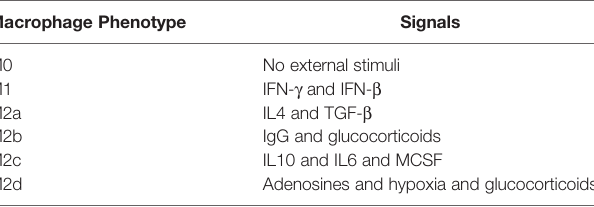
TABLE 3 | Microenvironments associated with speci fi c macrophage